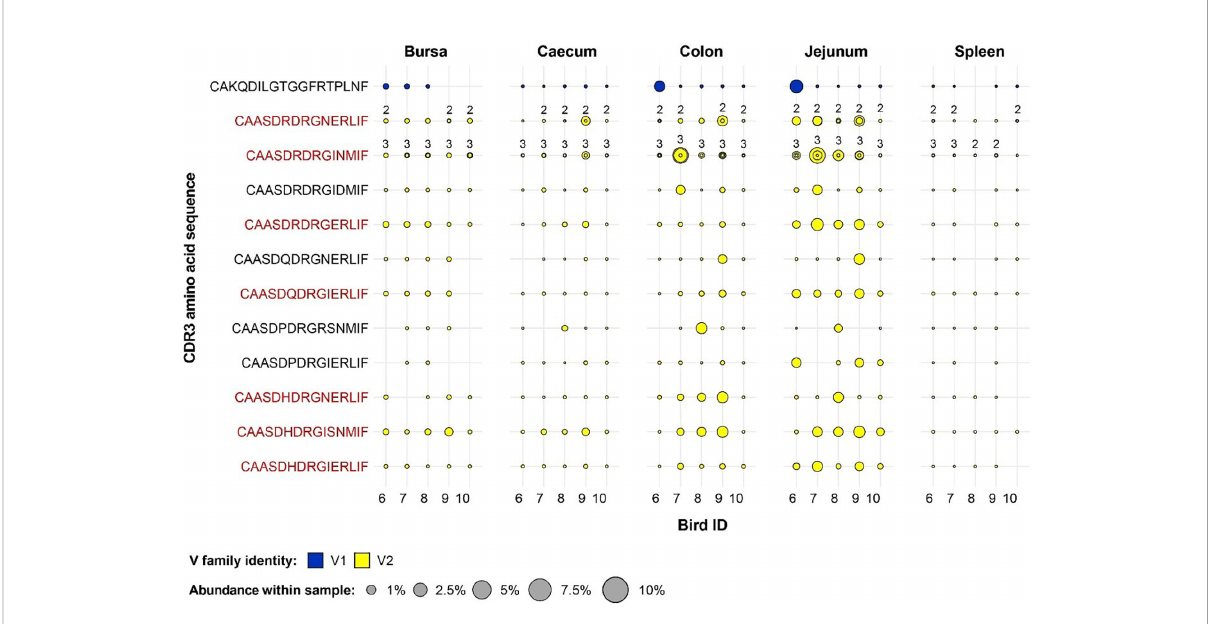
FIGURE 12 Clonal expansions in the restricted repertoire of germ-free birds. Circles indicate the presence of clones with a speci fi c CDR3 amino acid sequence and are proportional to the abundance within each bird ’ s tissue clonal compartment. Overlapping circles display different clones based on nucleotide sequence which share the same CDR3 amino acid sequence. The number of convergent CDR3 nucleotide sequences recovered from the samples is displayed on top of the circles, if two or more are present. The plot shows only the clones which are preferentially expanded in the germ-free birds (at or above 0.5% and at less than 0.5% in the conventional). Colours indicate V family identity: blue – V1 and yellow – V2. CDR3 amino acid sequences which are expanded in multiple birds are shown in